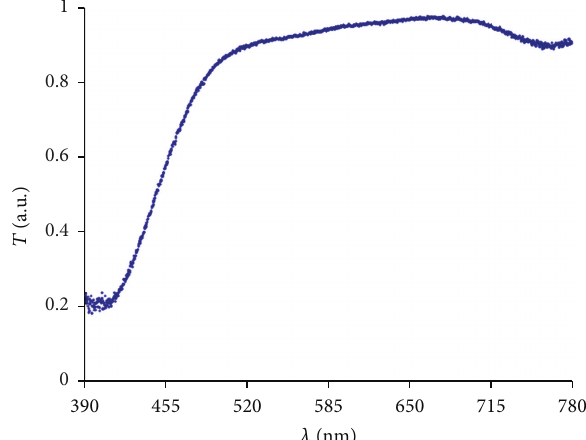
Figure 4: Example of a measured transmittance curve for an IOL (Hoya